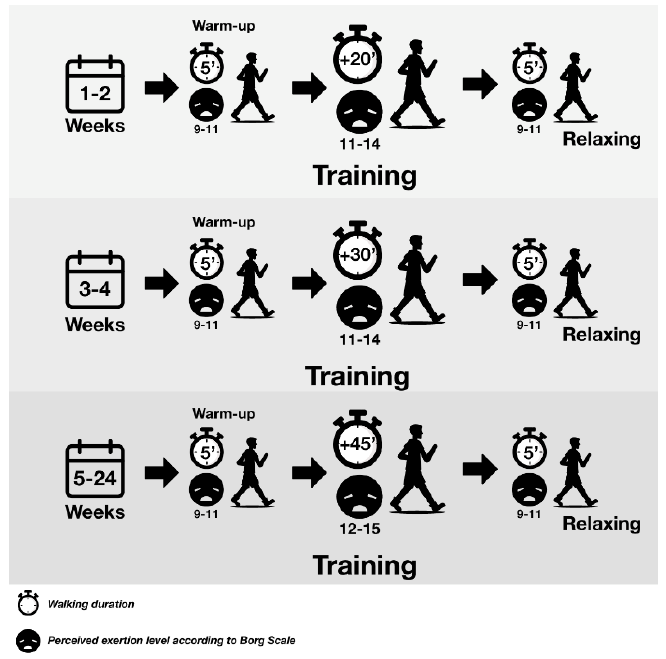
Figure 2. The walking program carried out at least five days a week according to the degree of perceived exertion by the Borg scale.